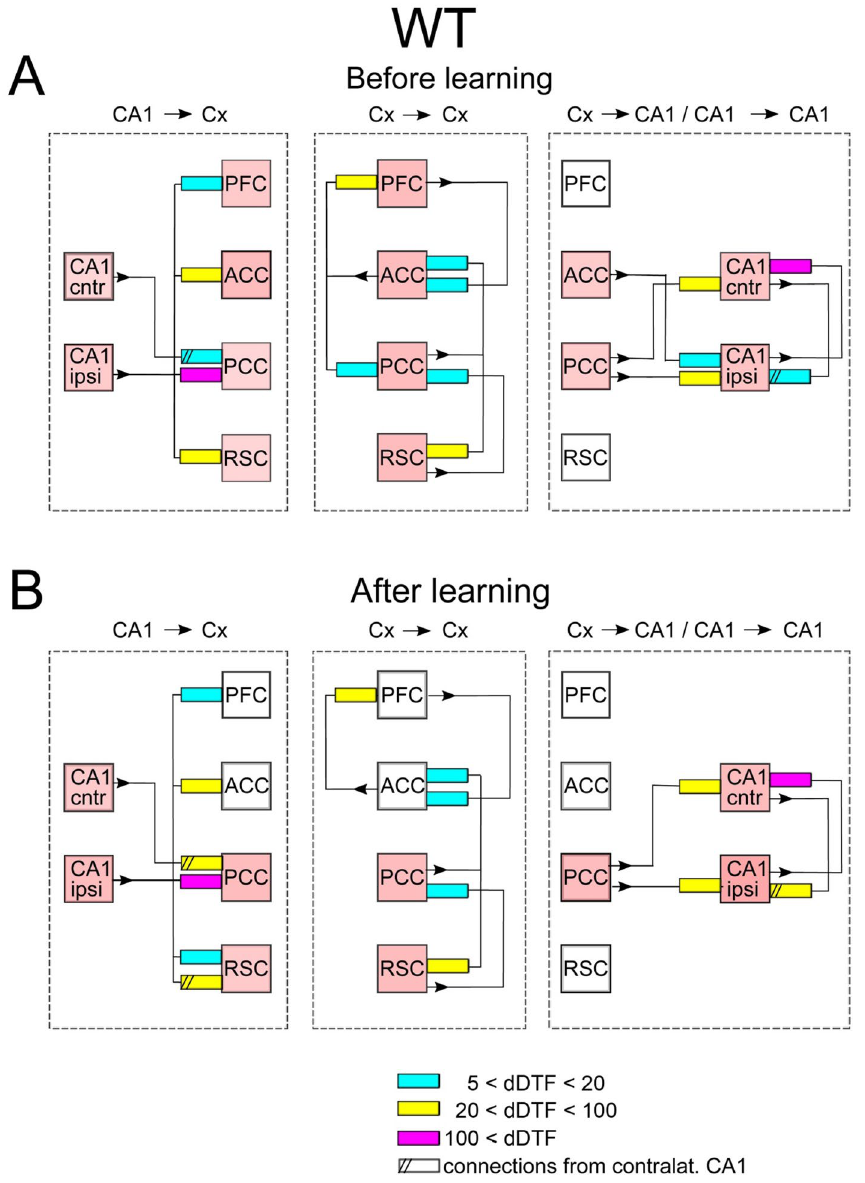
Figure 4. Scheme of coupling between brain structures in WT mice during SWRs. Before learning session slow gamma oscillations are synchronized among all cortices as indicated by pink squares. Notice that after learning the loop PFC → ACC → PFC becomes partly disconnected from the main loop of hippocampal–cortical– hippocampal transmission. The organization of the picture as in Fig.